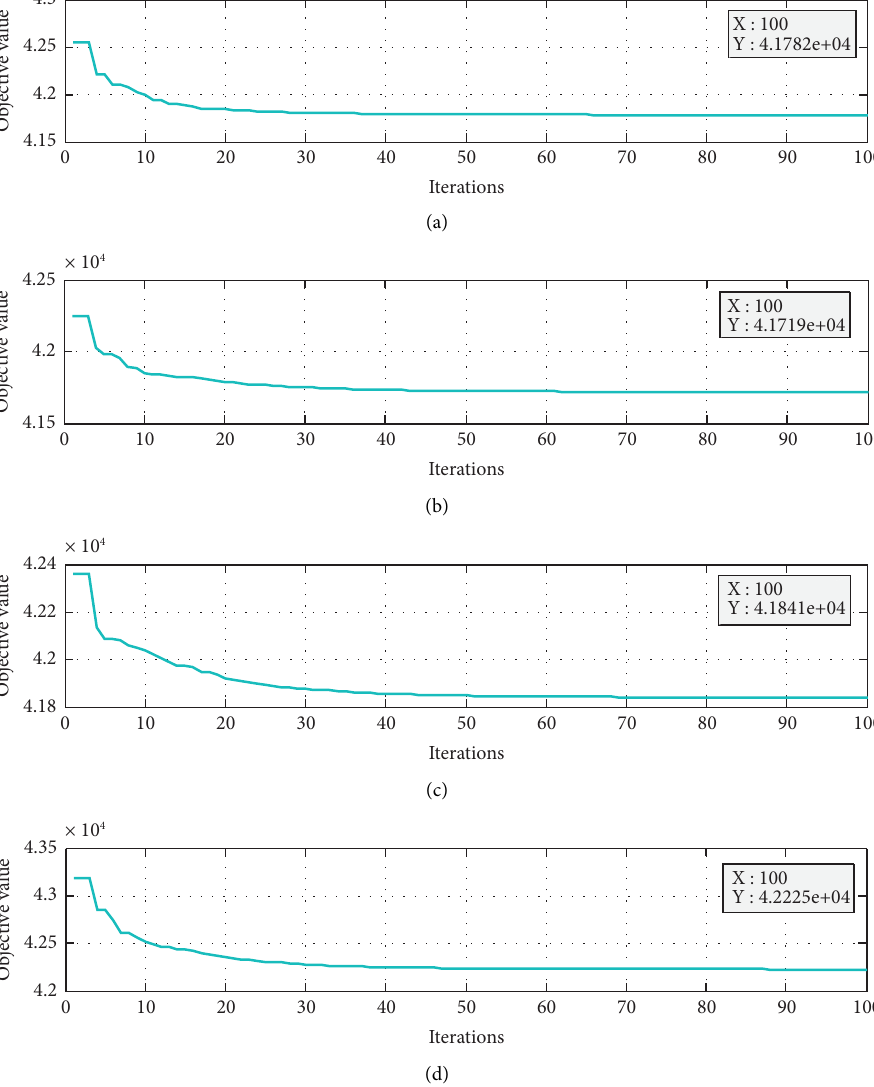
Figure 12: Convergence characteristic curves for multiobjective OPF (case 22 through case 25) of the IEEE 57-bus system: (a) Case 22; (b) Case 23; (c) Case 24; (d) Case